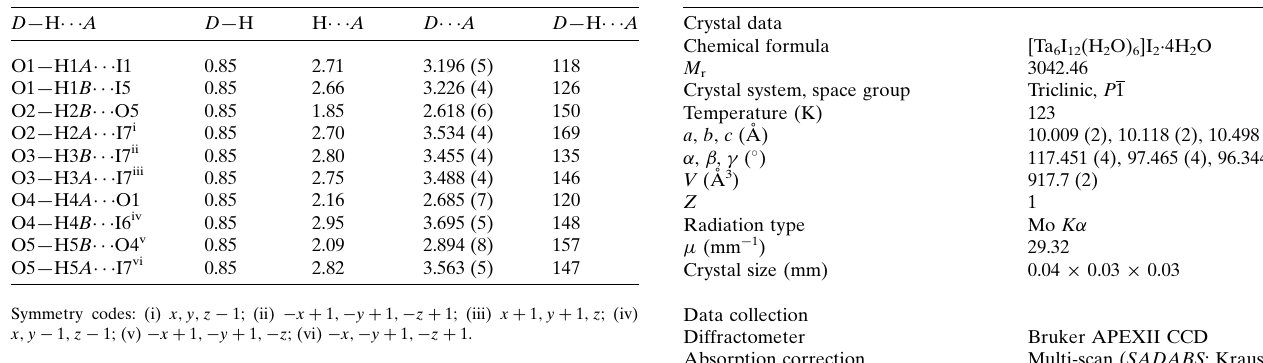
Table 1 Hydrogen-bond geometry (A˚ , (cid:3) ).